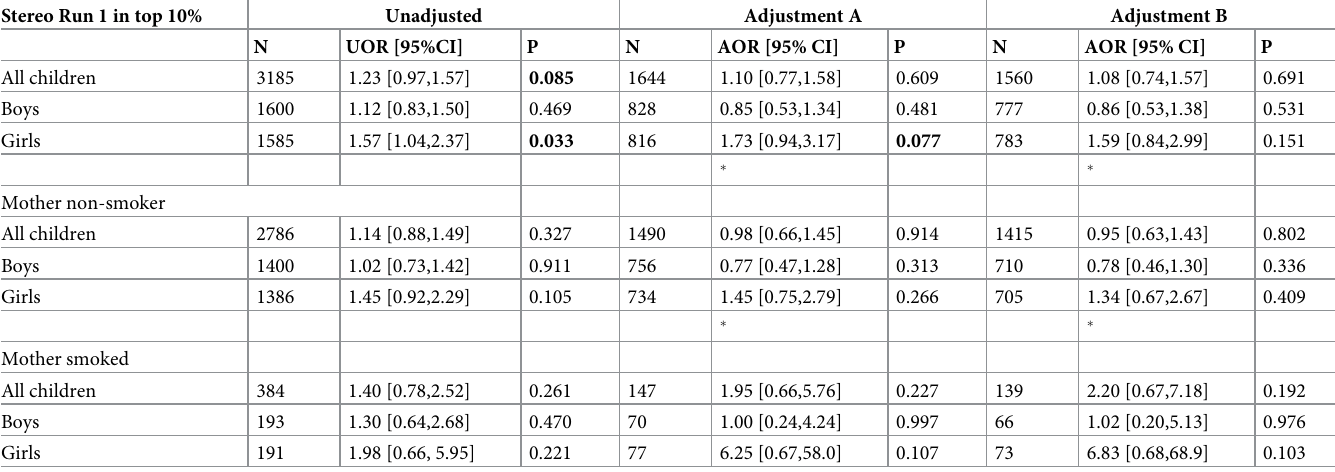
Table 7. Odds ratio showing risk of stereo run 1 volume level being in the top 10% where paternal grandmother smoked. Adjustment A concerns allowing for pater- nal grandmother’s year of birth, her ethnicity, and her education level; Adjustment B additionally takes the paternal grandfather’s social class into account. Stereo Run 1 in top